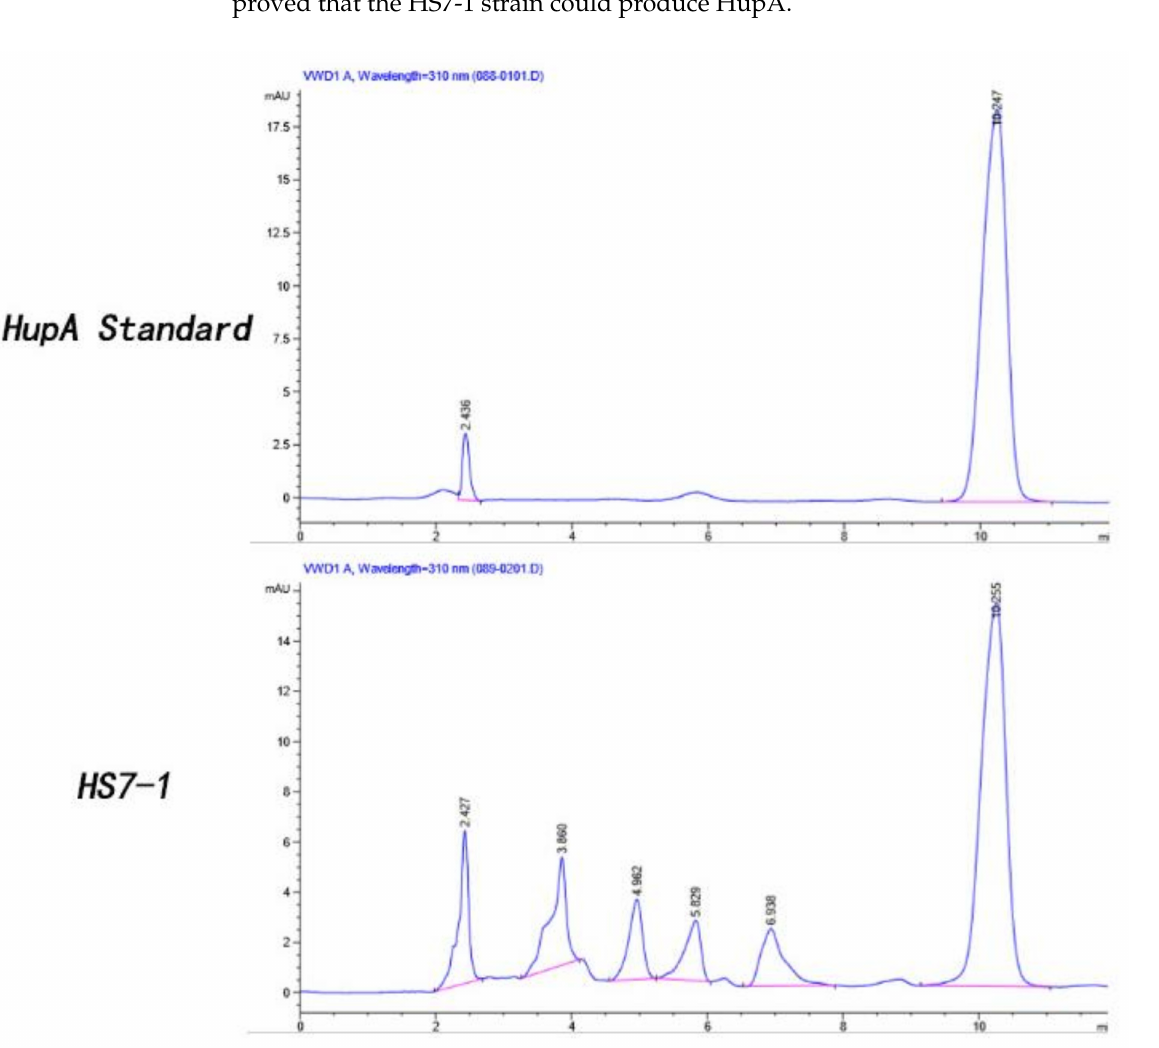
Figure 8. HPLC histogram of the standard HupA and HS7-1 strain crude alkaloid extract. From the data in Table 1, it was observed that the yield of HupA per gram of dried mycelia was 3.7 µ g/g, and for the control, the detected concentration was 4.4 µ